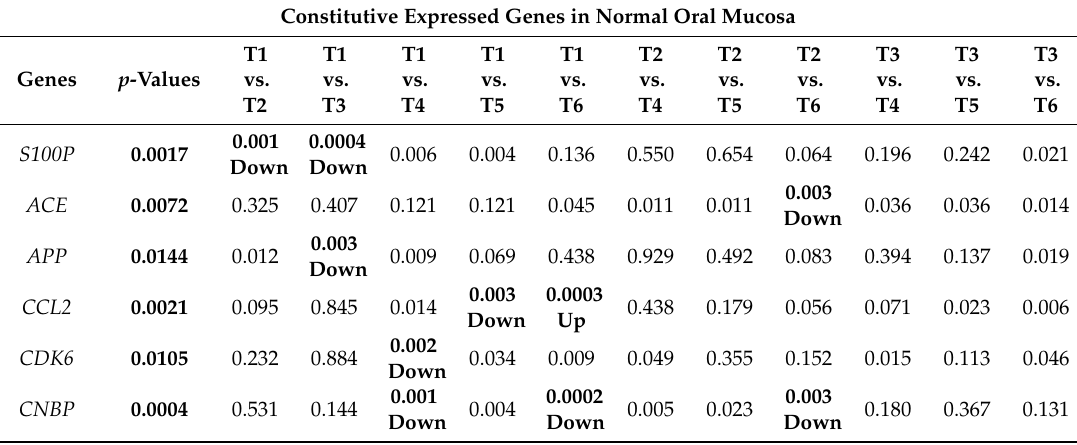
Table 5. Di ff erentially expressed genes coding for constitutive proteins in normal oral